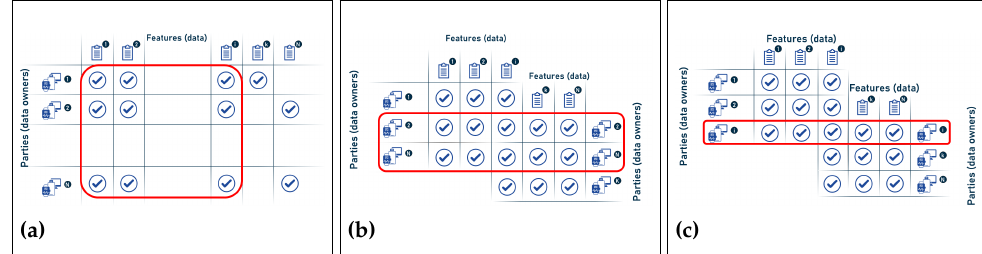
Figure 5. ( a ) Horizontal FL; ( b ) vertical FL; and ( c ) federated transfer learning.